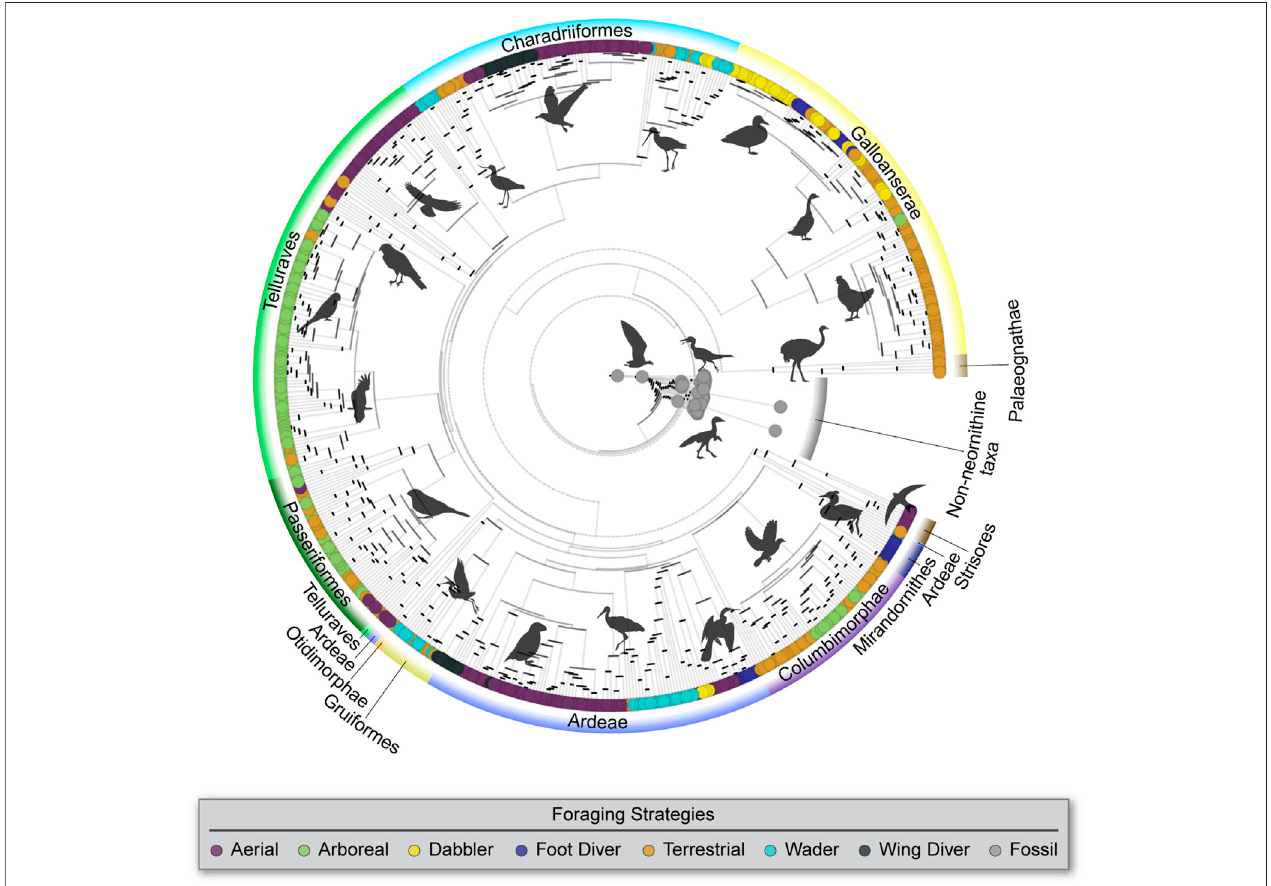
FIGURE 1 | Phylogenetic tree compiled from the study of Hackett et al. (2008) for modern birds and from Wang et al. (2016), Chiappe et al. (2019), and Hu et al. (2020) for Mesozoic birds, with branches color coded by foraging strategy and phylogenetic grades used in this analysis labeled.